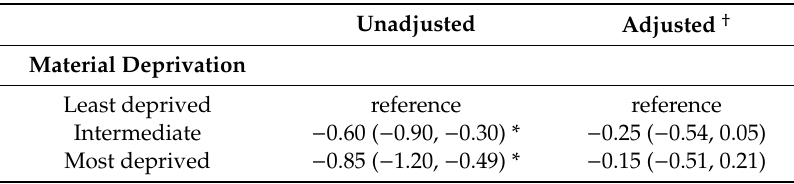
Table 3. Mean di ff erence in diet quality (95% CI) of participants living in more materially-deprived areas versus least deprived areas, results from unadjusted and adjusted linear mixed-e ff ect models (LMMs). Unadjusted Adjusted † Material Deprivation Least deprived